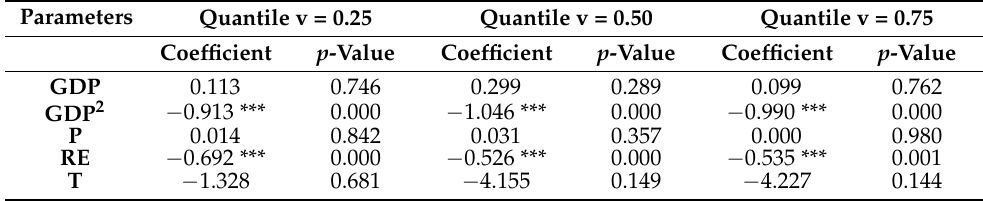
Table 6. Estimates of QARDL